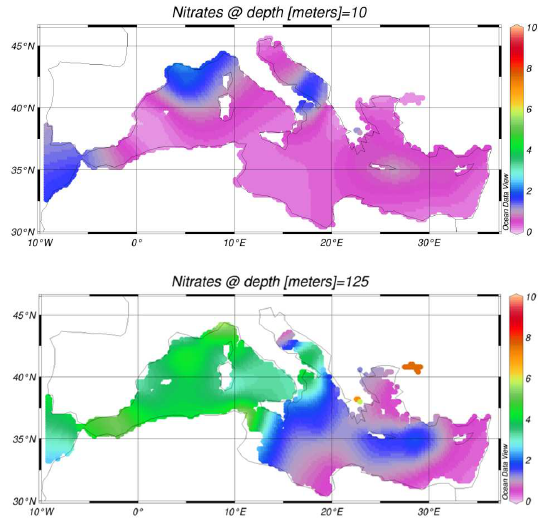
Fig. 4. Average nitrate concentration (µmoll − 1 ) at 10m (upper Fig.4. Average nitrateconcentration ( µ moll − 1 )at10m(upperpanel) and125m(lowerpanel)inwinter. panel) and 125m (lower panel) in